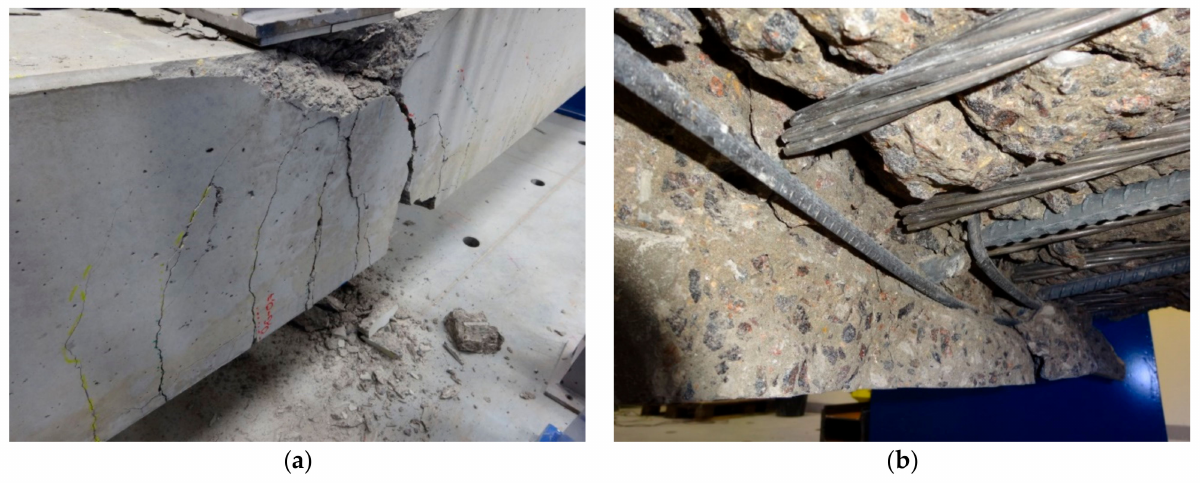
Figure 10. Failure of NSC beam: crack pattern ( a ), and rupture of pretensioned reinforcement ( b